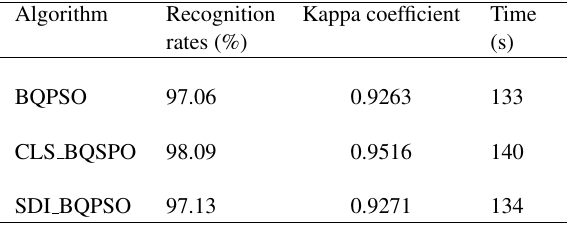
Table 1. Accuracy assessments of the three methods